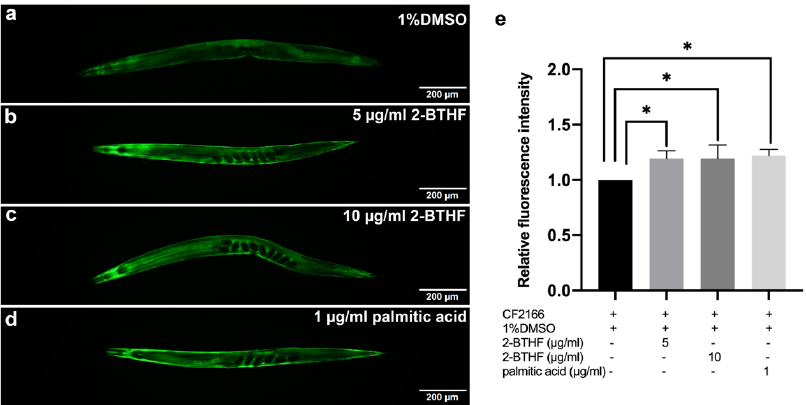
Figure 8. Effects of purified H. scabra compounds on GST-4 expression in transgenic CL2166 strain. GFP expression of the worms treated with 1% DMSO (control) ( a ), 5 µ g/mL 2-BTHF ( b ), 10 µ g/mL 2-BTHF ( c ), and 1 µ g/mL palmitic acid ( d ) is shown. The relative fluorescence intensity of gst-4 p::GFP was quantified and shown ( e ). The results of gst- 4 GFP expression were analyzed by one-way ANOVA following Bonferroni’s method, * p < 0.05.